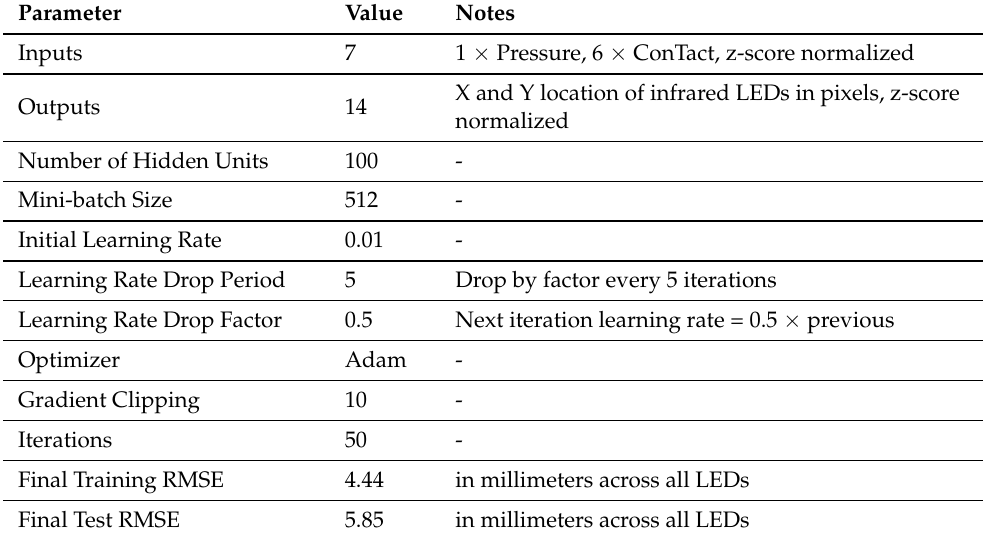
Table 1. Bidirectional Long Short-Term Memory (BiLSTM) model properties and hyperparameters. RMSE: root mean square